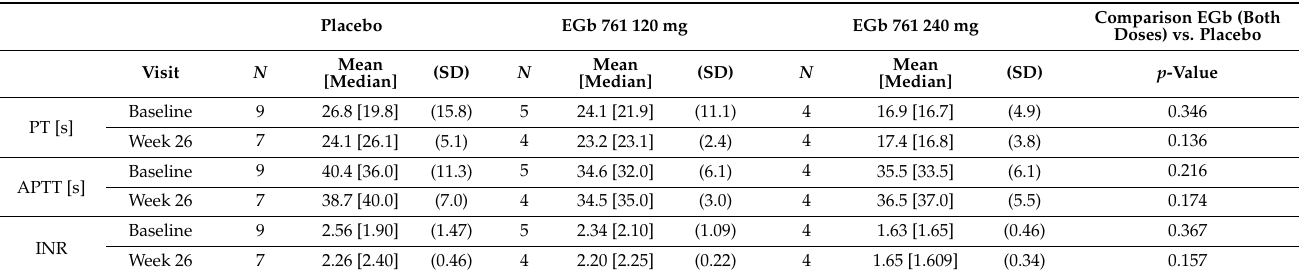
Table 4. Coagulation parameters of patients taking warfarin.